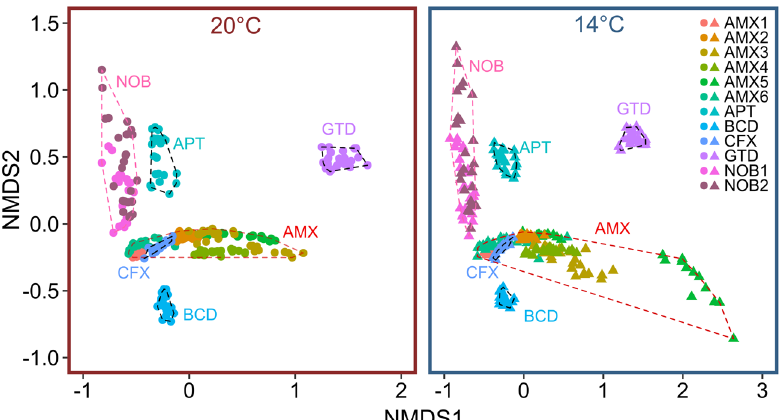
Fig. 7 Transcriptomic differences on the MAG level. nMDS (based on Jaccard dissimilarity) based on the COG expression pro fi le for each MAG. Colors denote different MAGs and dashed lines (ordihull function) highlight genus cluster. Each dot represents the COG pro fi le of the corresponding MAG on a respective time-point. Left panel presents the 20 °C and right panel the 14 °C experiment. Stress value: